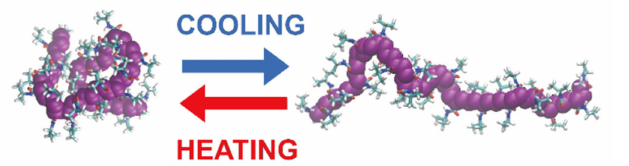
Figure 4. Schematic representation of a coil-to-globule lower critical solution temperature (LCST) transition. Adapted with permission from [97], copyright by Elsevier,